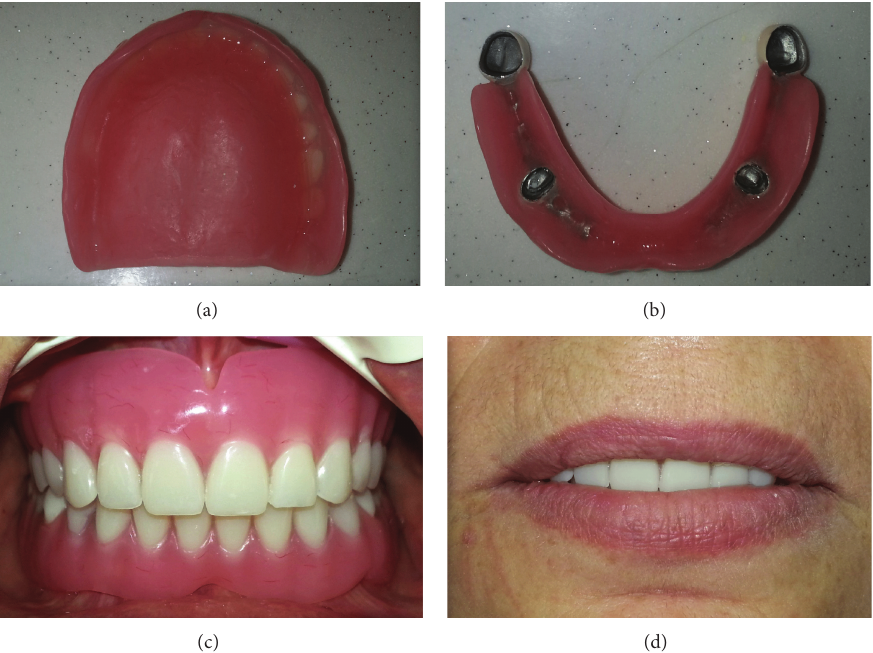
Figure 2: The image of the (a) temporary denture and (b) overdenture. (c) Intraoral view and (d) frontal view of the dentures.